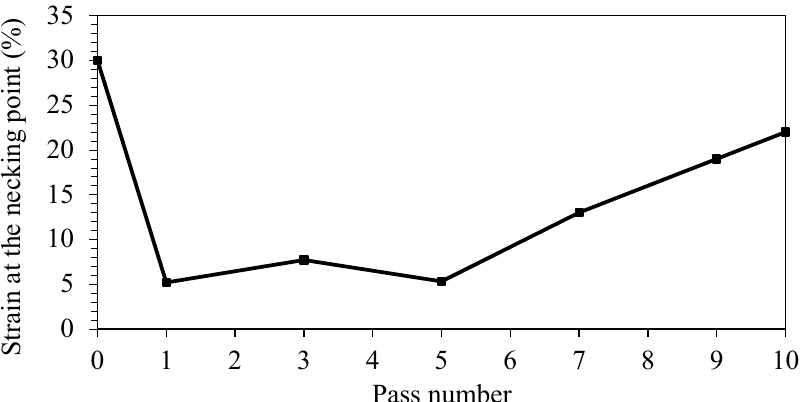
Figure 10. The value of strain at the necking point versus pass number in the tensile test of modified-CSP.